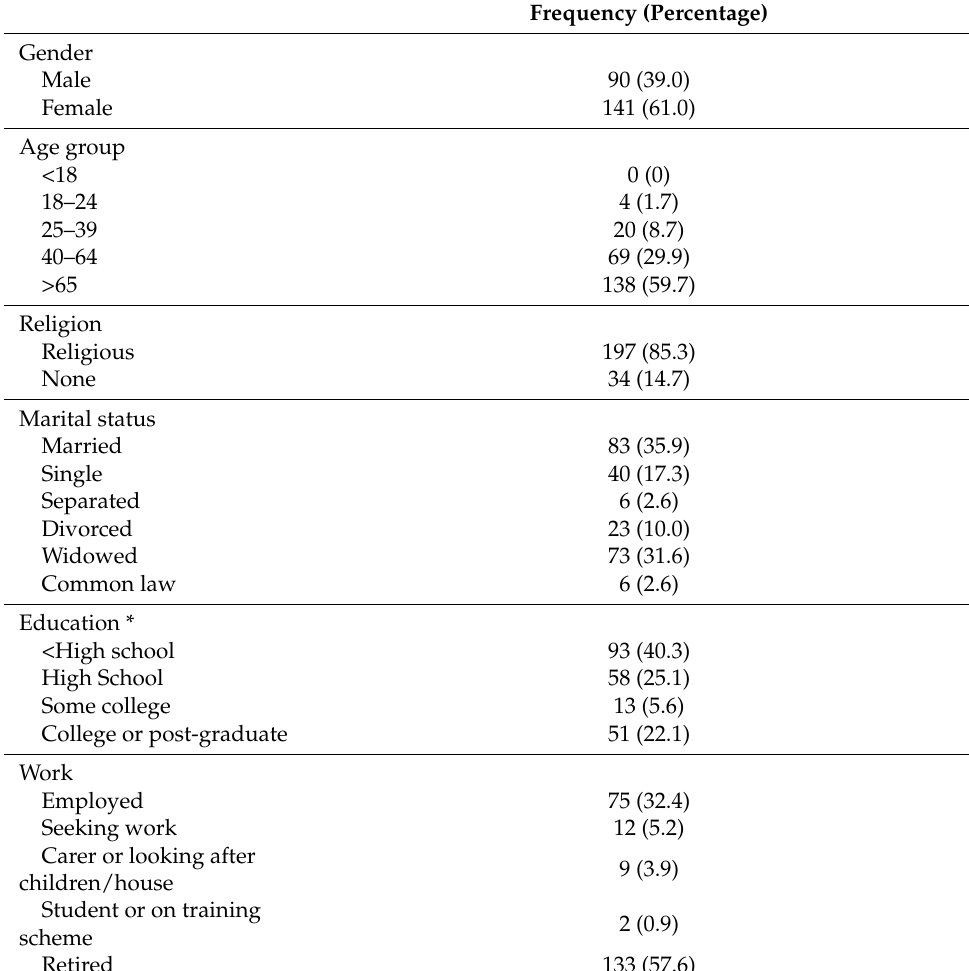
Table 1. Demographic characteristics of the study